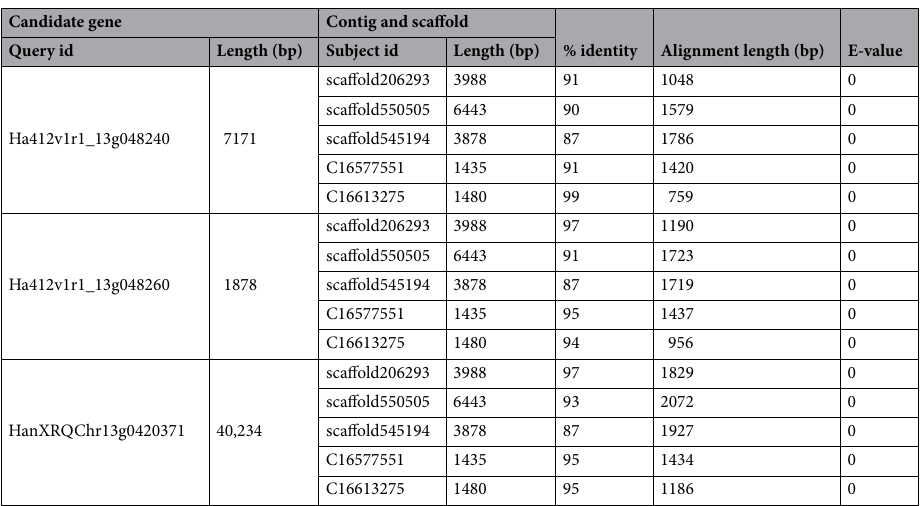
Table 4. Summary of the sequence identify between the Rf5 candidate genes and selected scaffolds and contigs from the HA-R9 whole-genome resequence.